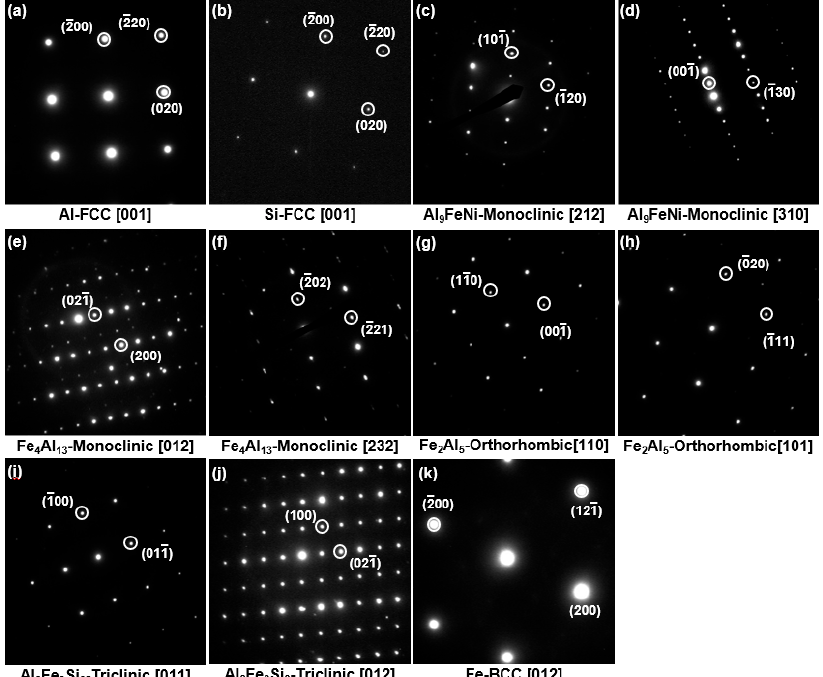
Figure 8. Diffraction patterns and those key diagram taking from area denoted as 1 – 11 in Figures 6 and 7, respectively. ( a ) Al, ( b ) Si, ( c , d ) Al 9 FeNi(T), ( e , f ) Fe 4 Al 13 ( θ ), ( g , h ) Fe 2 Al 5 ( η ), ( i , j ) Al 2 Fe 3 Si 3 ( τ 1 ), ( k ) Fe.